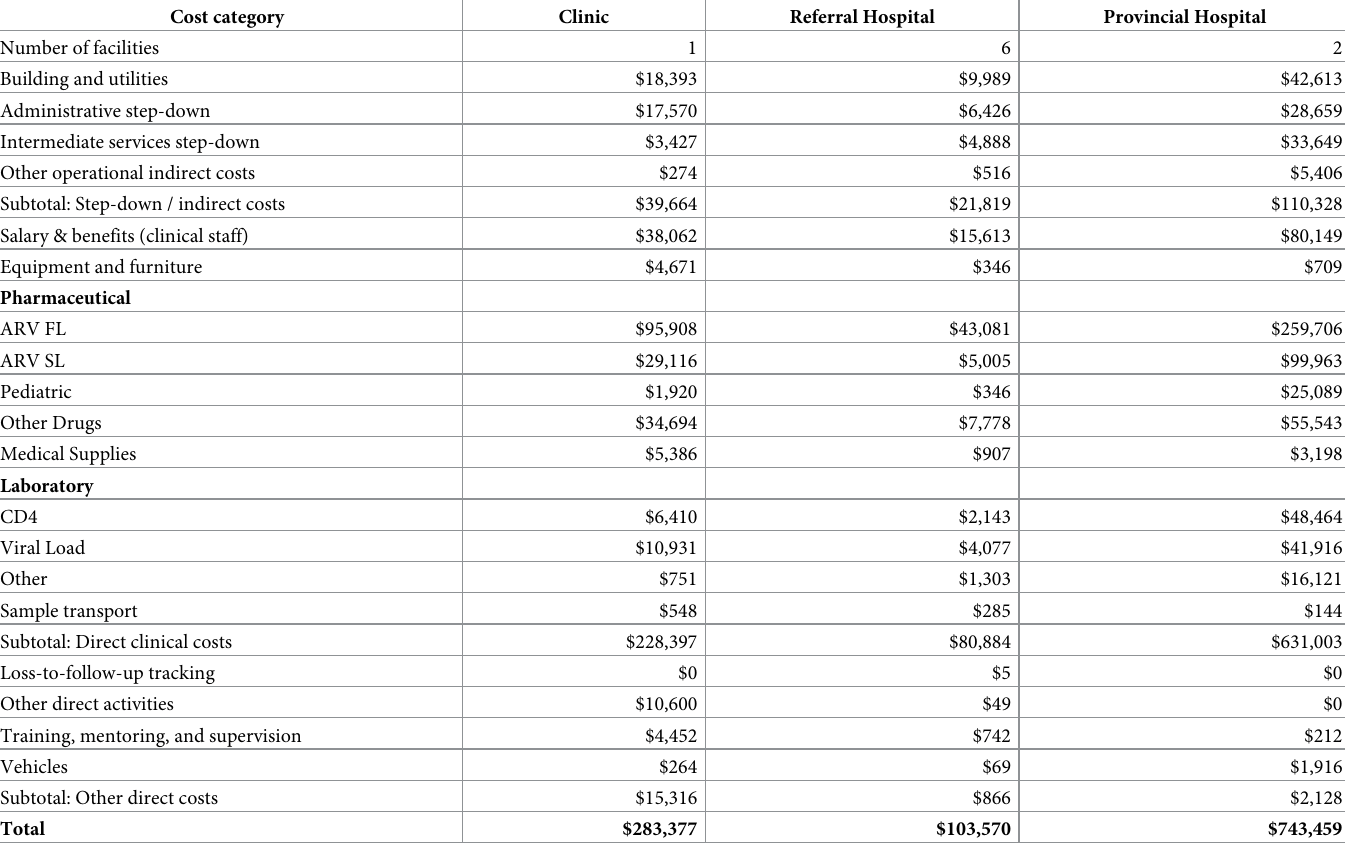
Table 4. Total costs for ART services per year, average by type of